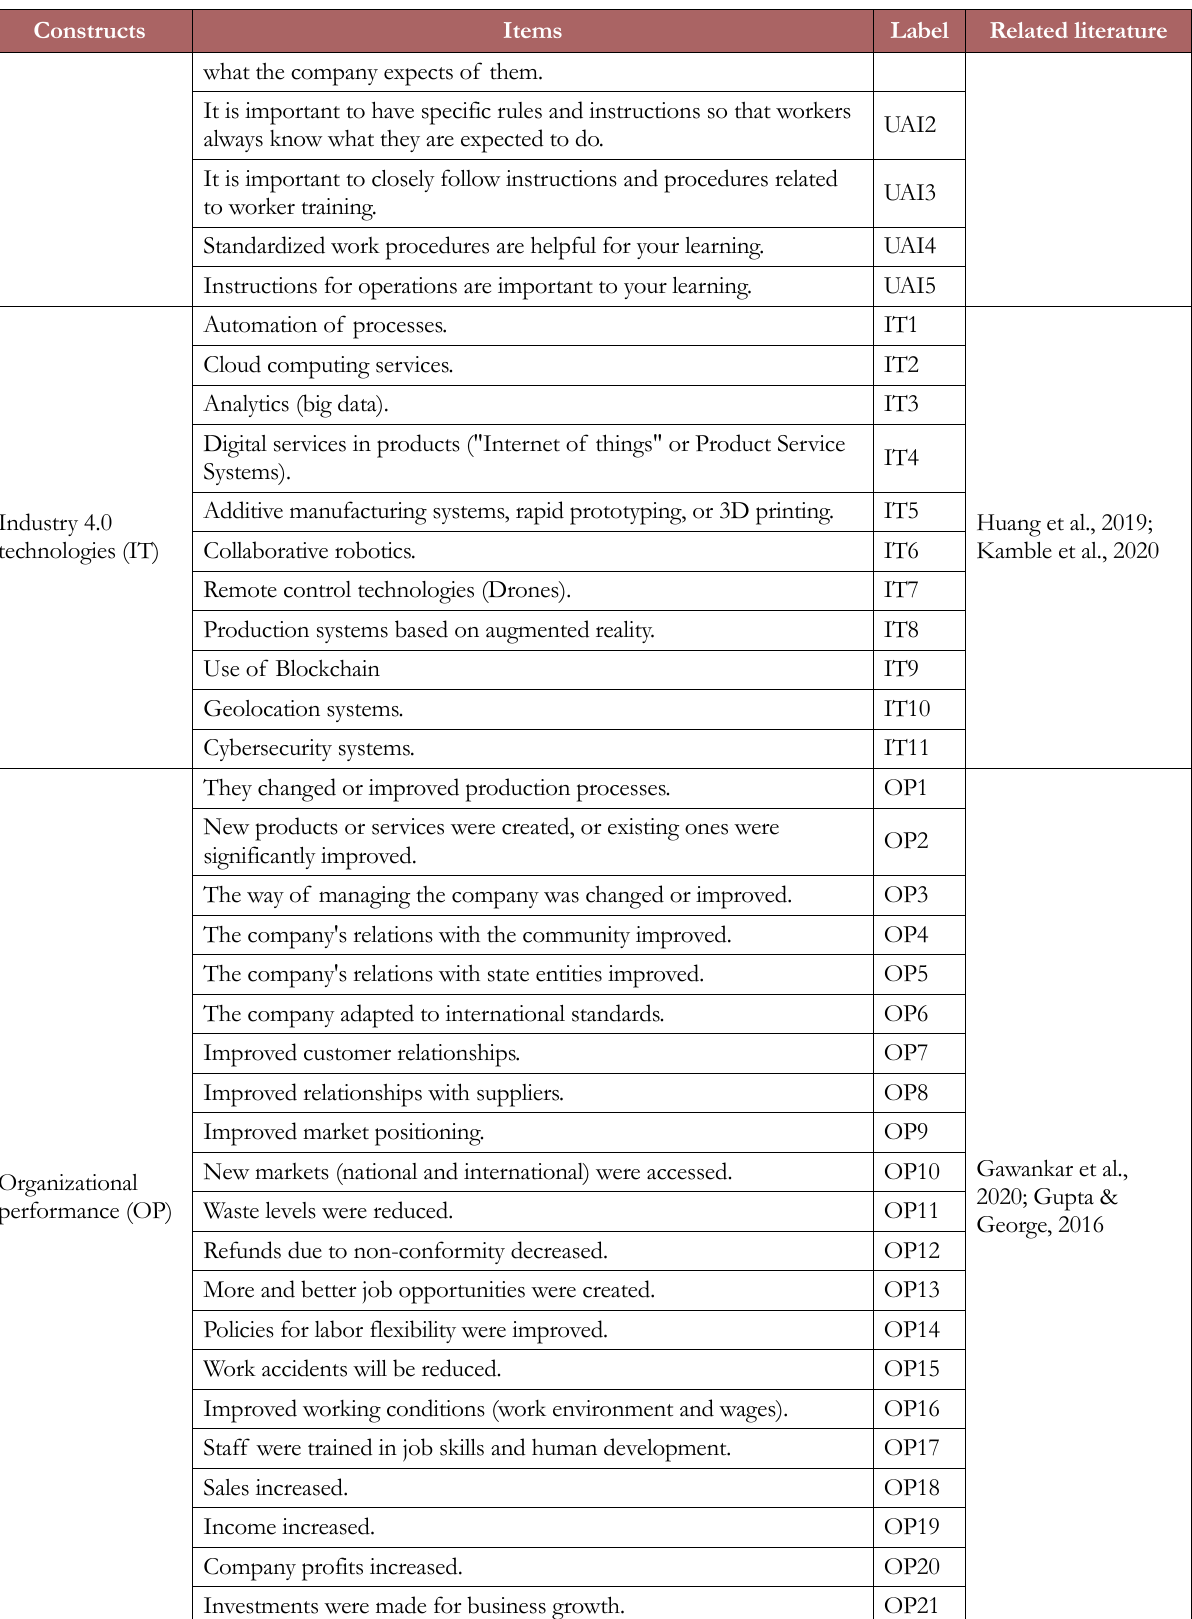
Table 1. Scale items for